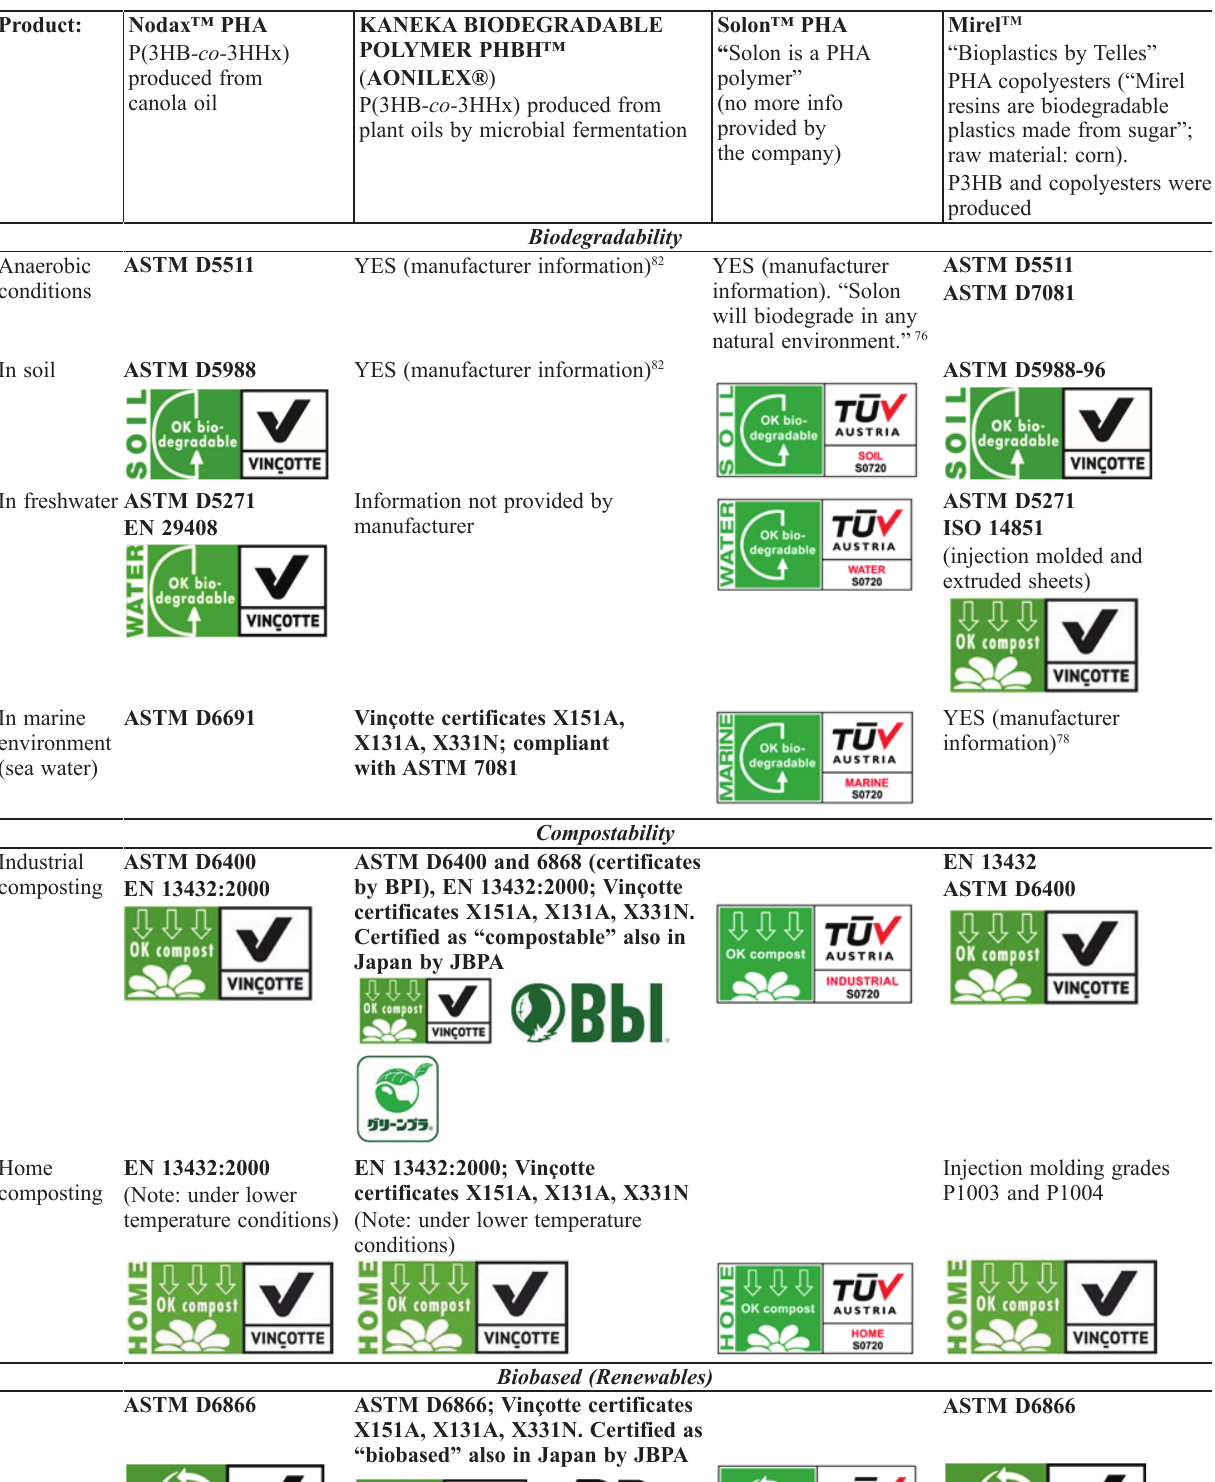
Table 2 – Certifications and labels for commercialized PHA Nodax™ PHA (Danimer Scientific), 77 KANEKA